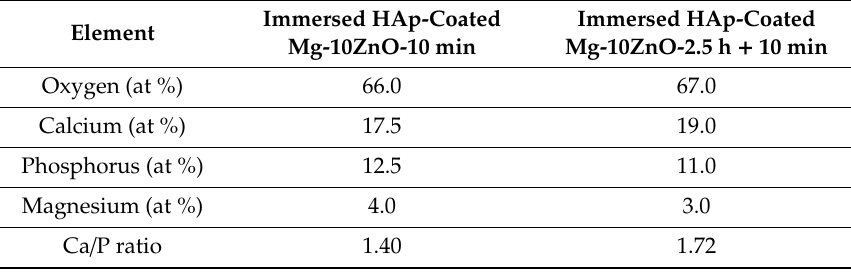
Table 3. EDS analysis results on the surfaces of immersed HAp-coated composites.